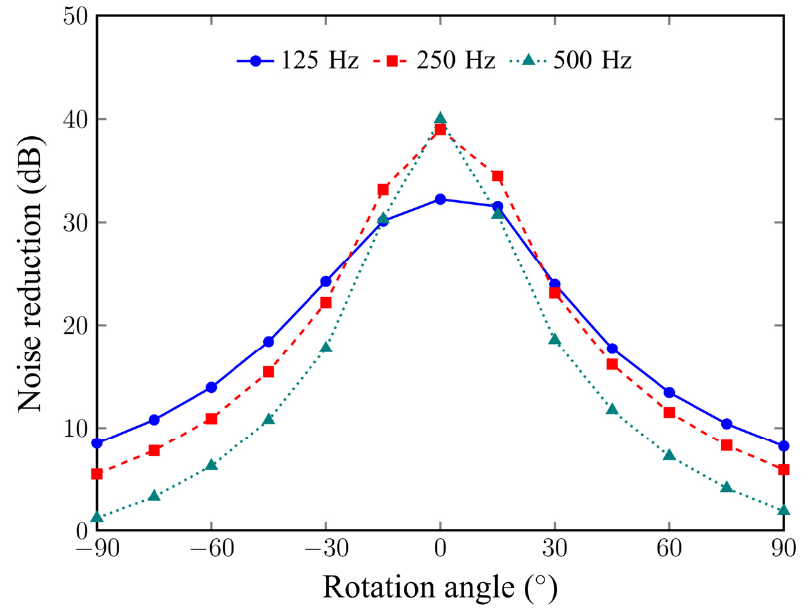
Figure 9. Noise attenuation with conventional control at different frequencies.